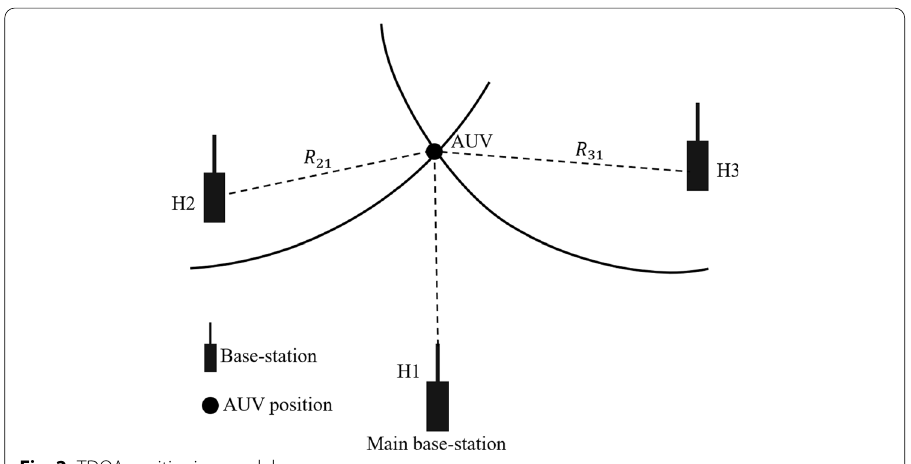
Fig. 2 TDOA positioning